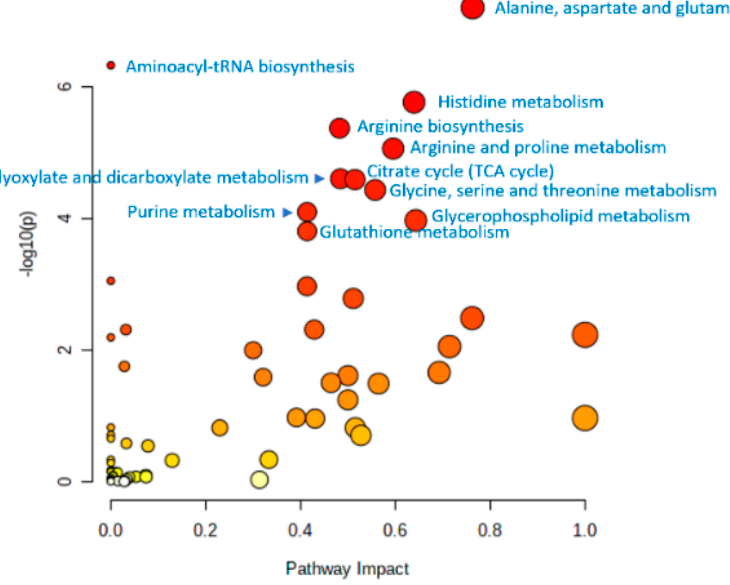
Figure 4. Summary graph of animal and human models for metabolic pathways potentially involved in aging processes. Graph was generated by the metabolite set enrichment analysis (MSEA) using the MetaboAnalyst program (www.metaboanalyst.ca; accessed on 18 September 2022) (“pathway analysis” option) by projecting metabolites onto metabolic pathways. The list of all metabolites associated with aging, which are presented in the papers mentioned in this review, was used for projection. Names of metabolic pathways with statistically significant ( p < 0.01) enrichment with projected metabolites are shown. The p value evaluates whether a measured set of metabolites is represented in the pathway more than expected by chance within a given list of metabolites ( p values from the pathway enrichment analysis). Metabolic pathways of Homo sapiens (KEGG) were used to project metabolites. Pathway impact values are from the pathway topology analysis.